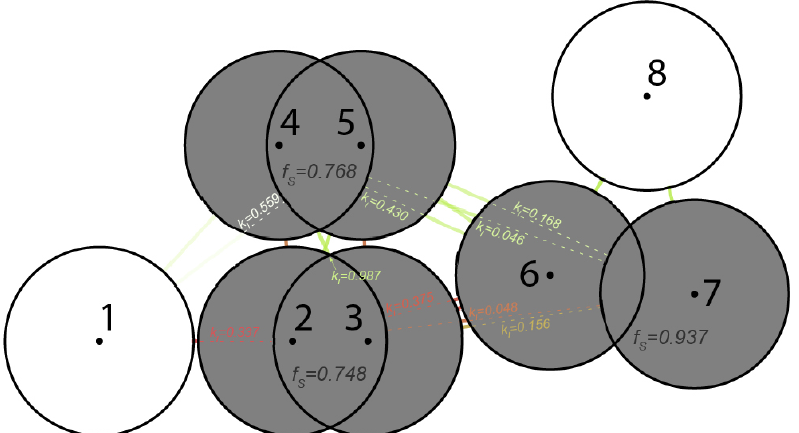
Figure 2. Illustration of the method used to calculate the forces between cells. While circles are normal cells, gray circles are dividing tumor cells. Green lines correspond to adhesive interactions, with the length of the bonds l > l 0 , and these lines become more transparent as l → l max . Orange and red lines denote repulsive interactions, with the length of the bonds l < l 0 , and these lines become darker with decreasing l . Dashed lines denote “hidden” parts of bonds. Coefficients of tumor cells area f S and coefficients of bond strengths k l are calculated according to Equations (3) and (7). For further explanations, see the